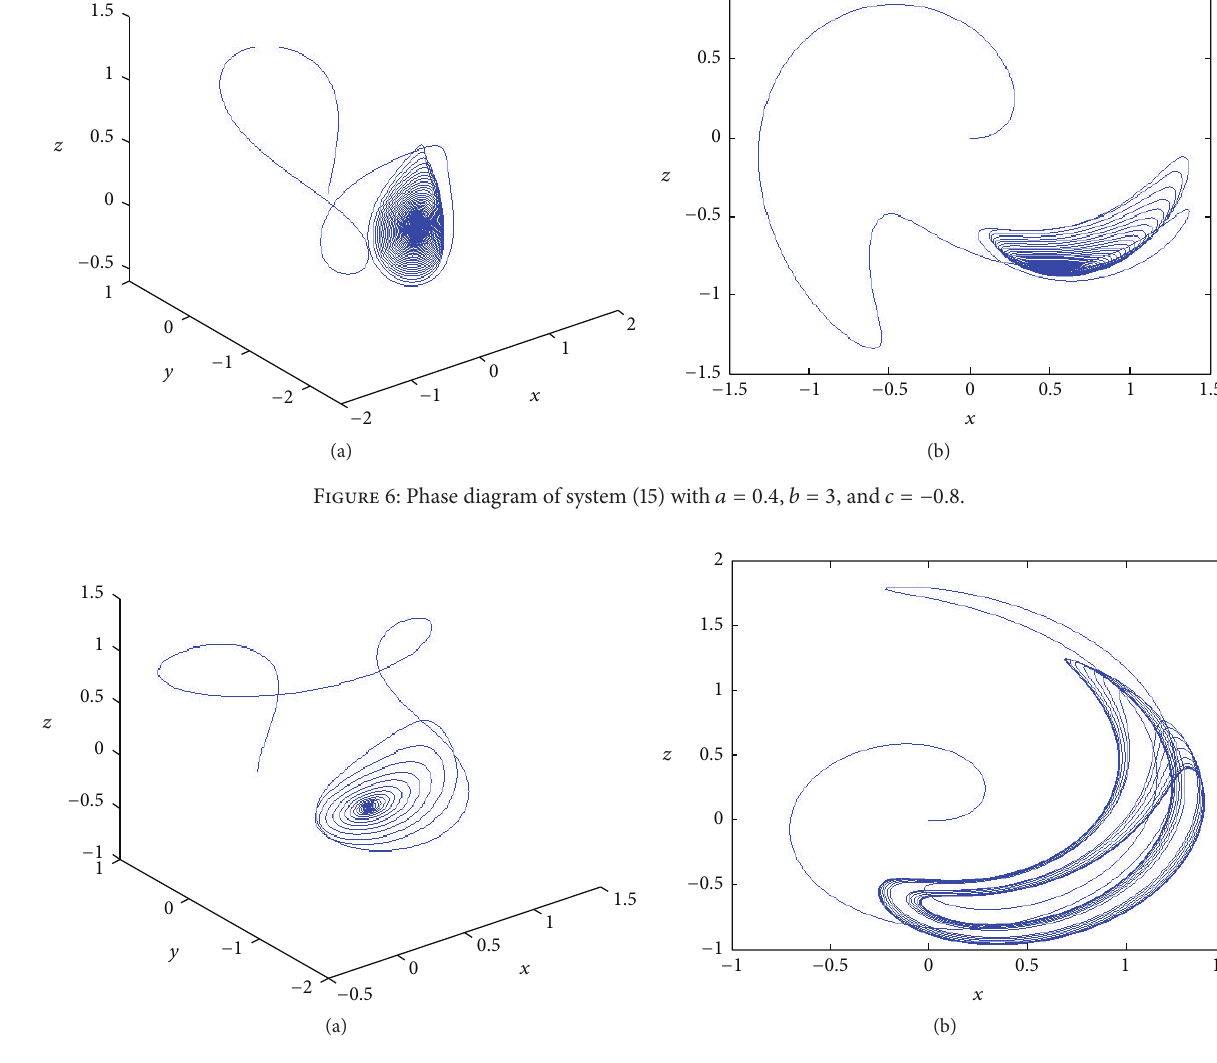
Figure 7: Phase diagram of system (15) with 𝑎 = 0.4 , 𝑏 = 3 , and 𝑐 = −1 .